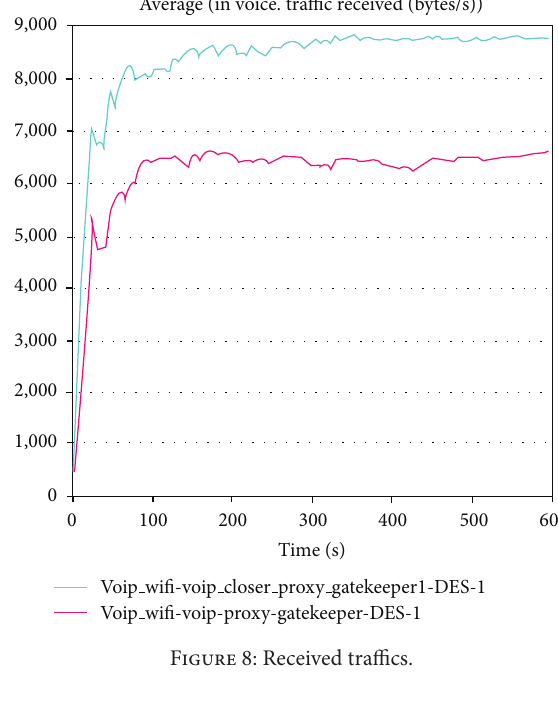
Figure 6: MOS average calculation.